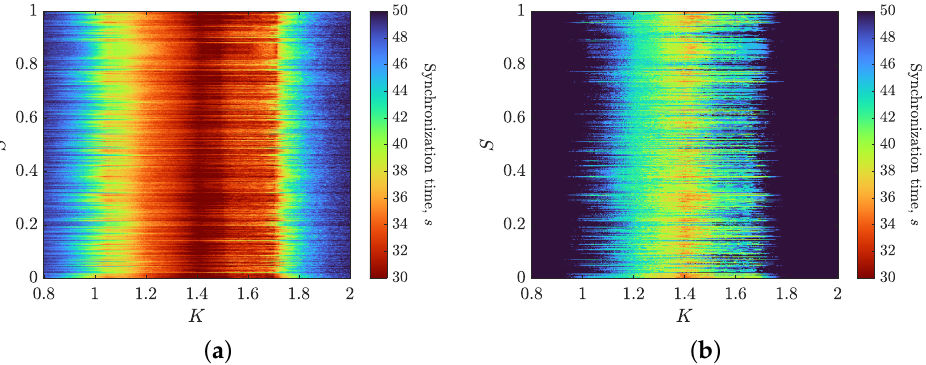
Figure 4. The dependence between average ( a ) and maximum ( b ) synchronization time and the symmetry and synchronization coefficients.